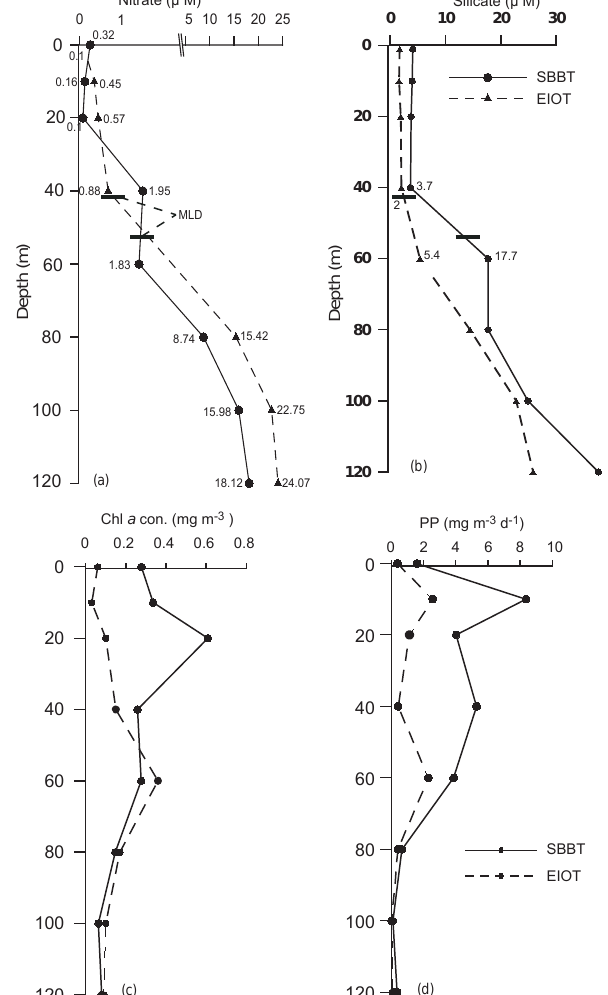
Fig. 11. Vertical profiles of (a) nitrate (µM) (b) silicate (µM) [Thick black line cutting across the profiles represent the mixed layer depth] (c) chlorophyll a (mgm − 3 ) and (d) primary production (mgCm − 3 ) in the vicinity of SBBT (solid line) and EIOT (broken line) during August